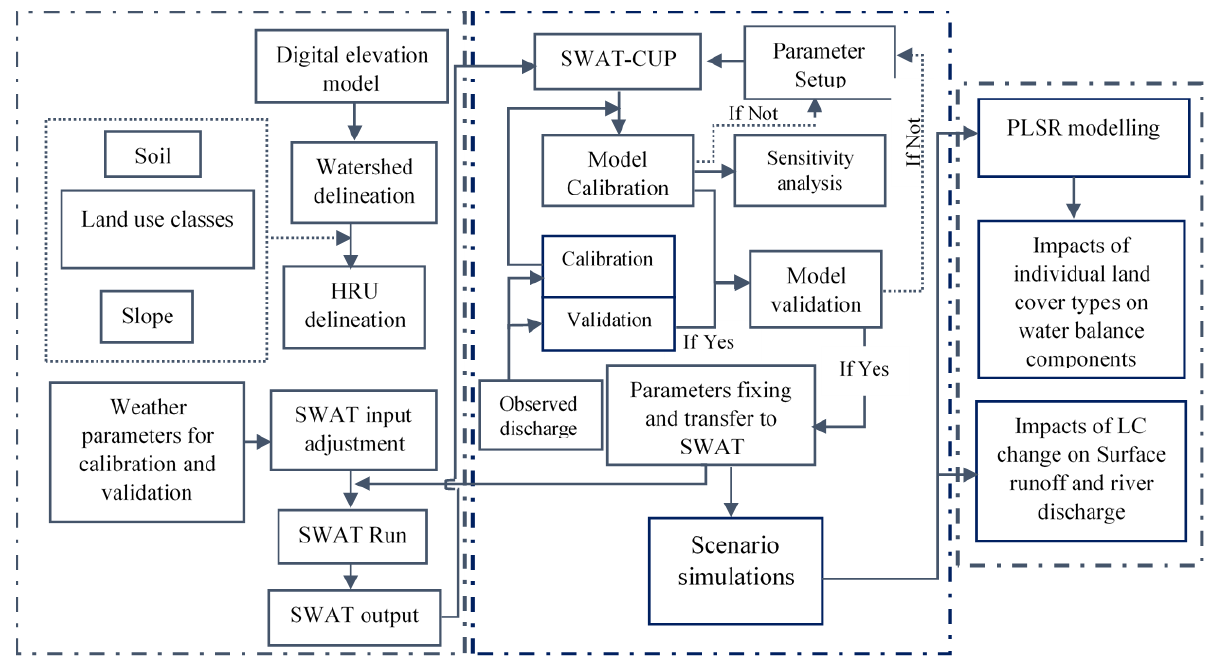
Figure 4. Workflow applied in this work.